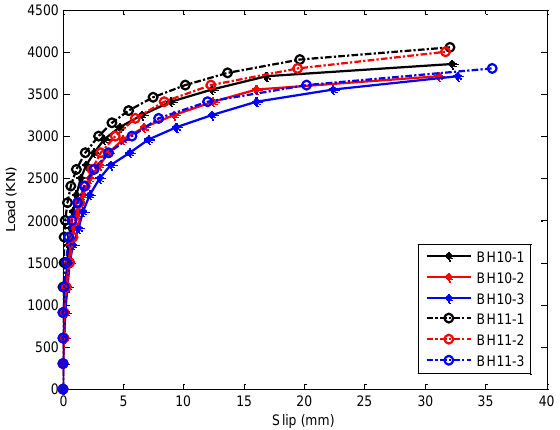
Figure 18. Load – slip relationship. Figure 18. Load–slip